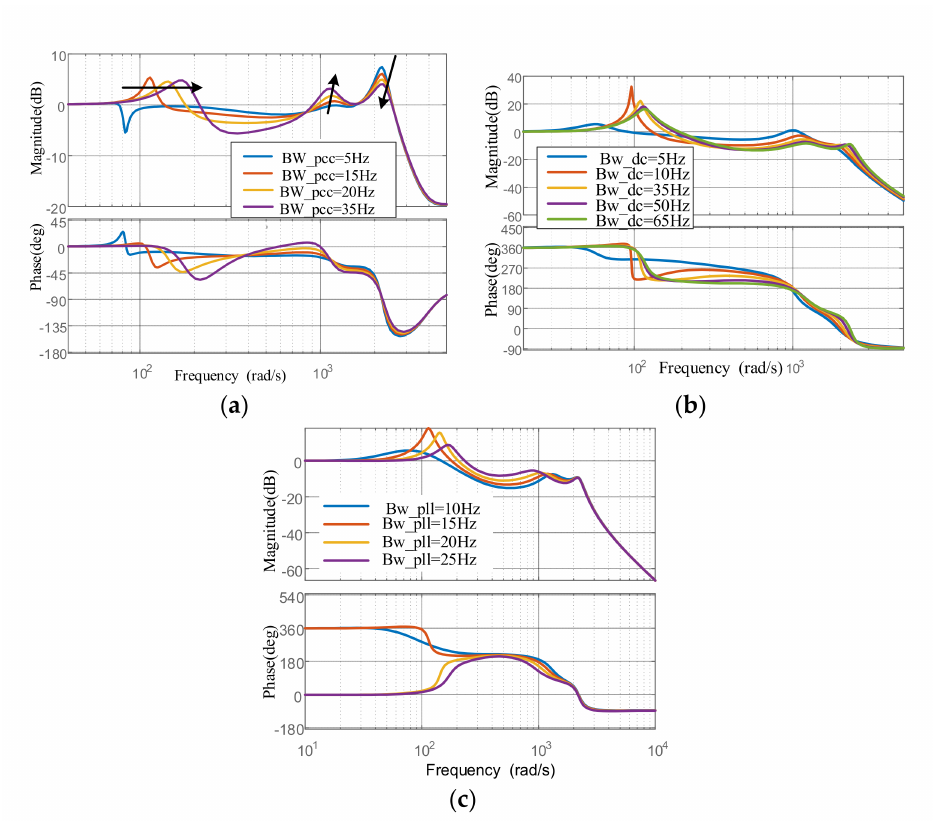
Figure 5. Frequency response of closed loop transfer function( a ), v pv /v mpp ( b ) and ( c ) v cd /v cdref